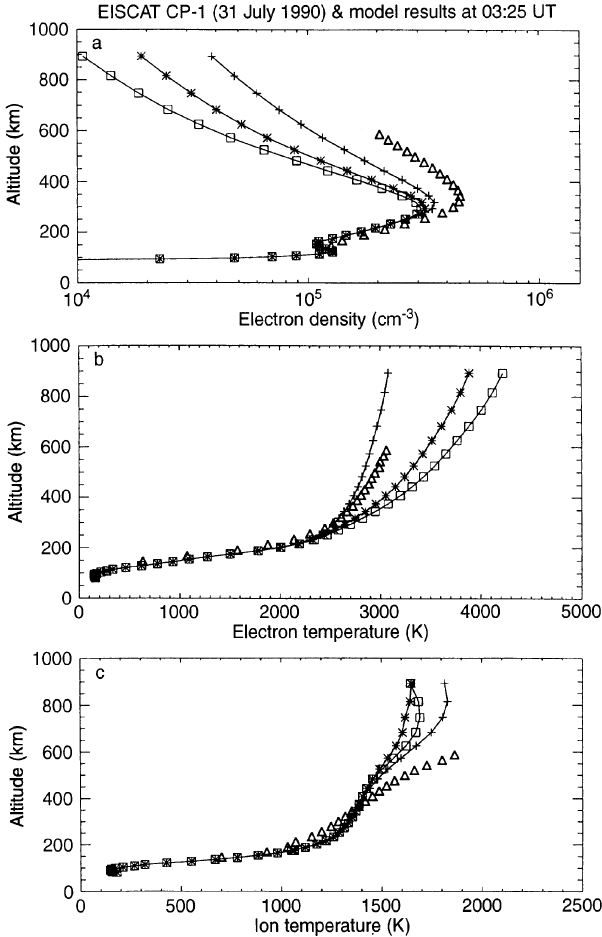
Fig. 4. As in Fig. 2, but showing the influence of varying photo- electron escape energy fluxes with maximum values of 6 (cid:93) 10 (cid:49)(cid:48) eV cm (cid:126)(cid:50) s (cid:126)(cid:49) ( curves with crosses ), 7 (cid:93) 10 (cid:49)(cid:48) eV cm (cid:126)(cid:50) s (cid:126)(cid:49) ( asterisks ) and 10 (cid:93) 10 (cid:49)(cid:48) eV cm (cid:126)(cid:50) s (cid:126)(cid:49) ( squares )